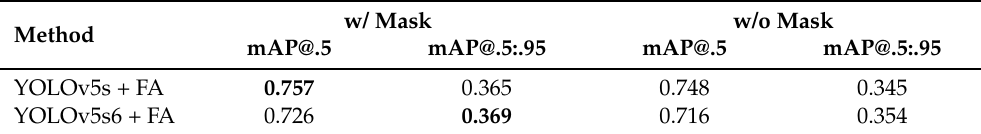
Table 5. Impact of mask.